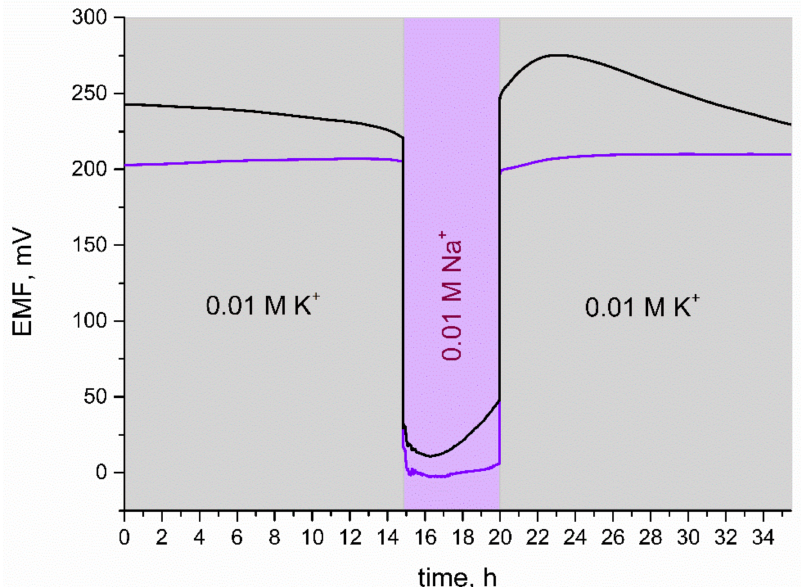
Figure 8. Water layer test: stability of potentiometric response of GC/IrO 2 · 2H 2 O/K + -ISM (purple line) and GC/K + -ISM electrode (black line) recorded in 0.01 M KCl and 0.01 M NaCl